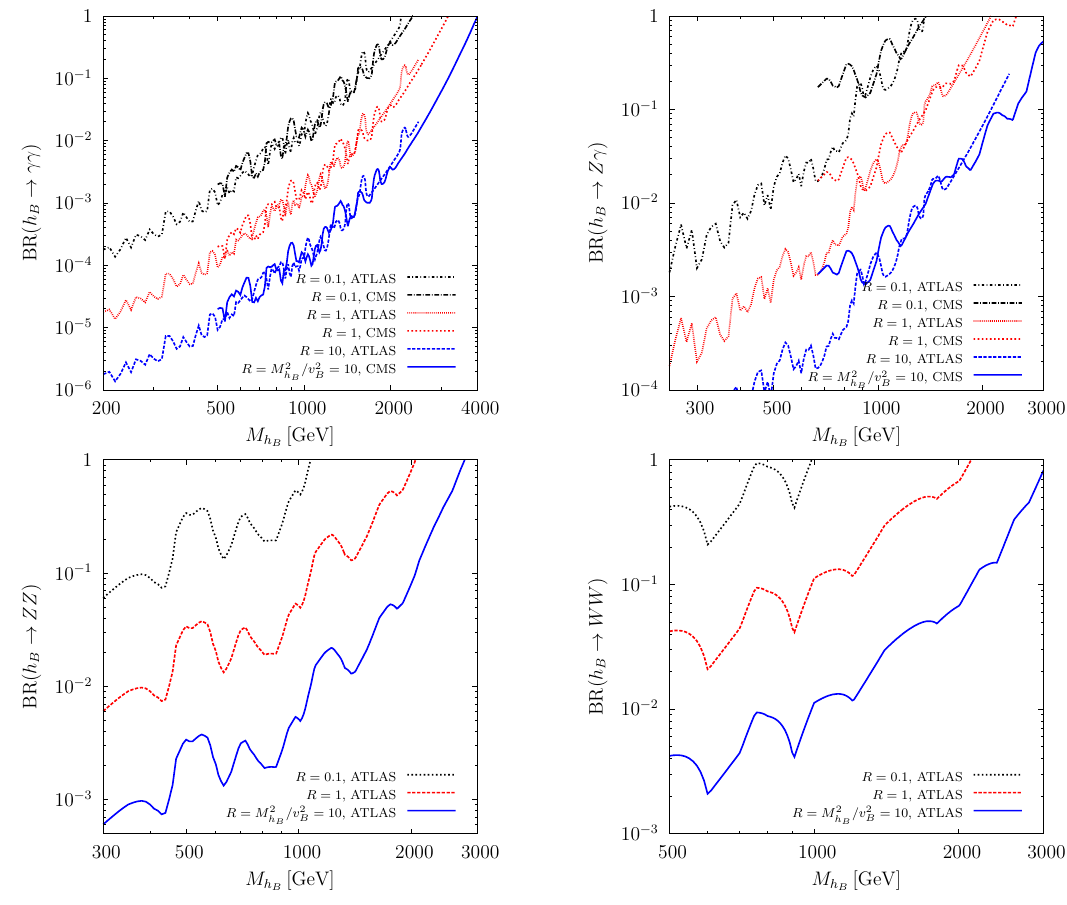
Figure 3 . Constraints on the branching ratios of h B into two photons [26, 27], Z(cid:13) [28, 29], ZZ [30], and WW [31] for di(cid:11)erent choices of the ratio between mass and vev of the baryonic Higgs (cid:12)eld. In the plots n f =